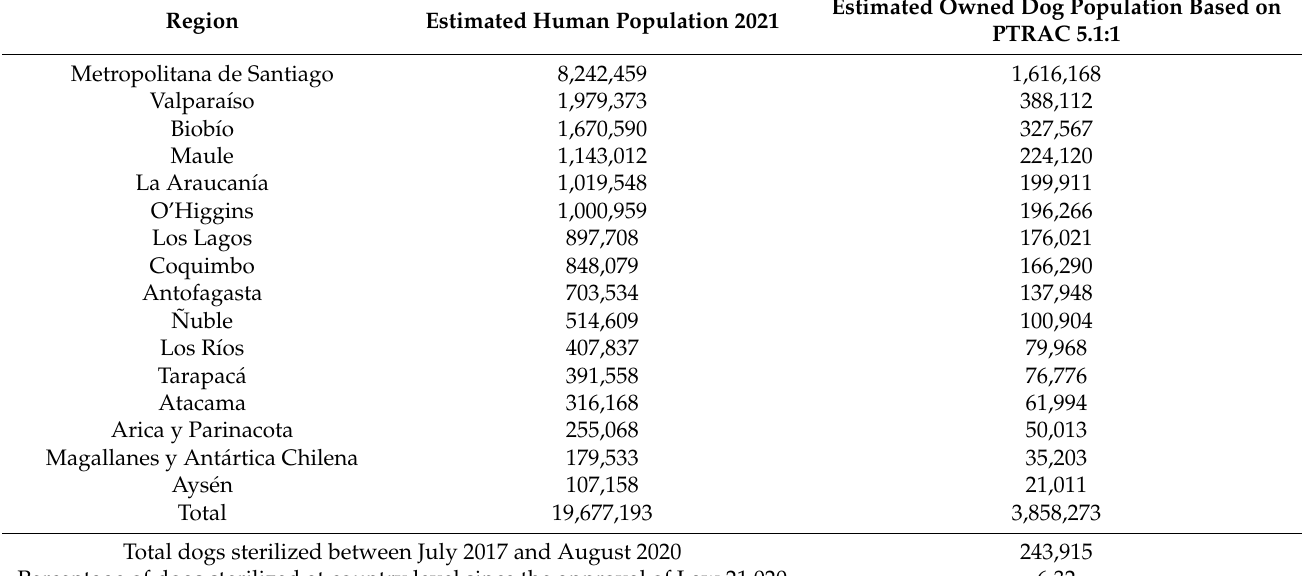
Table 1. Human populations by region of Chile in 2021 and estimated dog popu- lation using the PTRAC default of 5.1 humans per